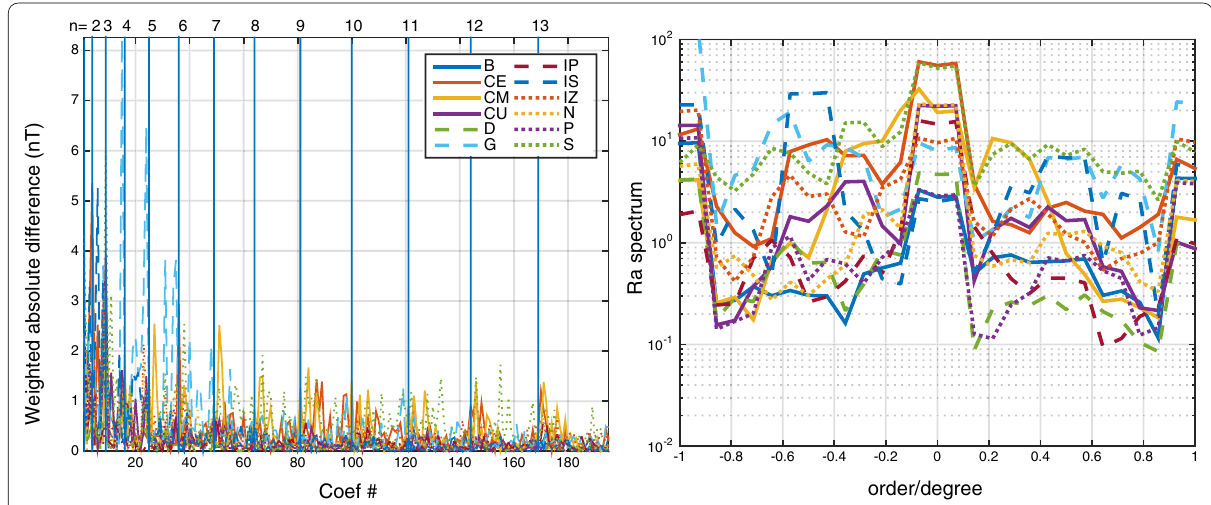
1 (left) and azimuthal power spectral differences (right) between the +